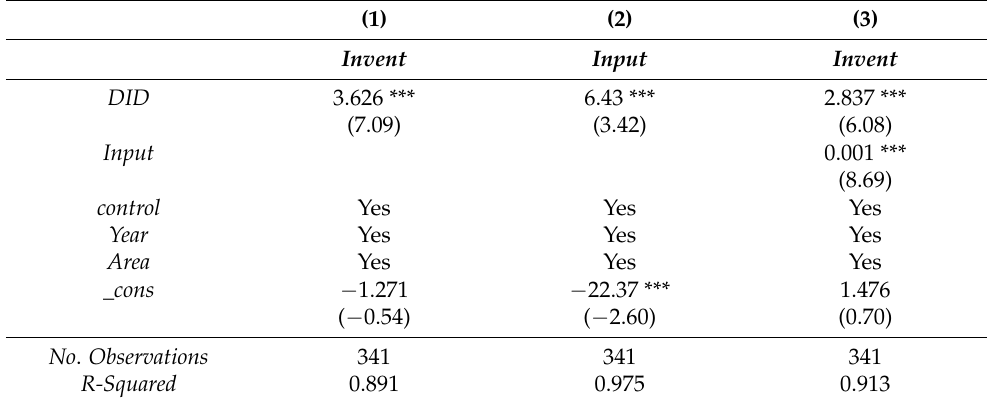
Table 5. Analysis of